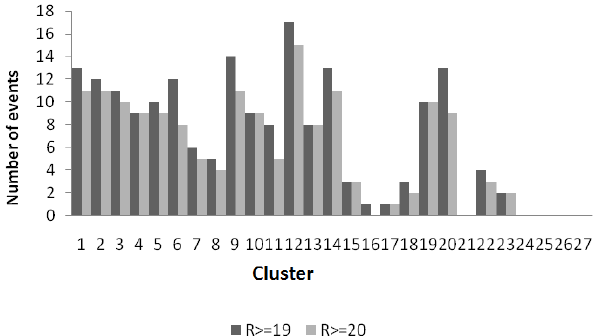
Fig. 6. Allocation of heavy rainfall events in the 27-cluster classification. Fig. 8. Typical geopotential height distribution pattern for Cluster 1, on 7 January 2000 (unit: gpm).